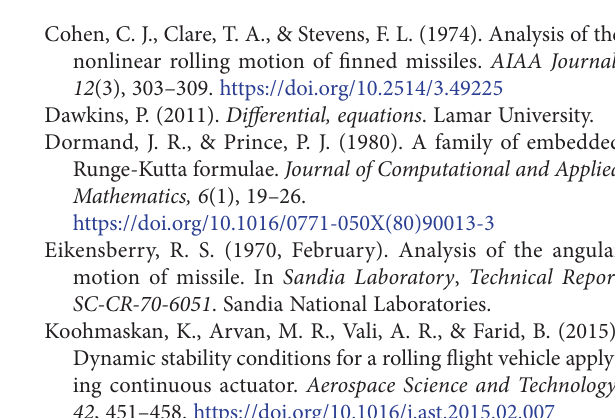
Figure 20. Comparison between closed form solution and linear 4-DOF model with real ON-OFF